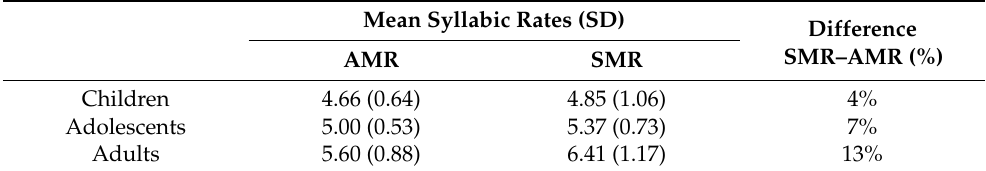
Table 1. Mean SMR and AMR syllabic rates in syllables per second (SD) for children, adolescents and